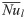
Effect of Ra and α on Nu¯l for the two selected porous matrixes in the case A = 4.0.